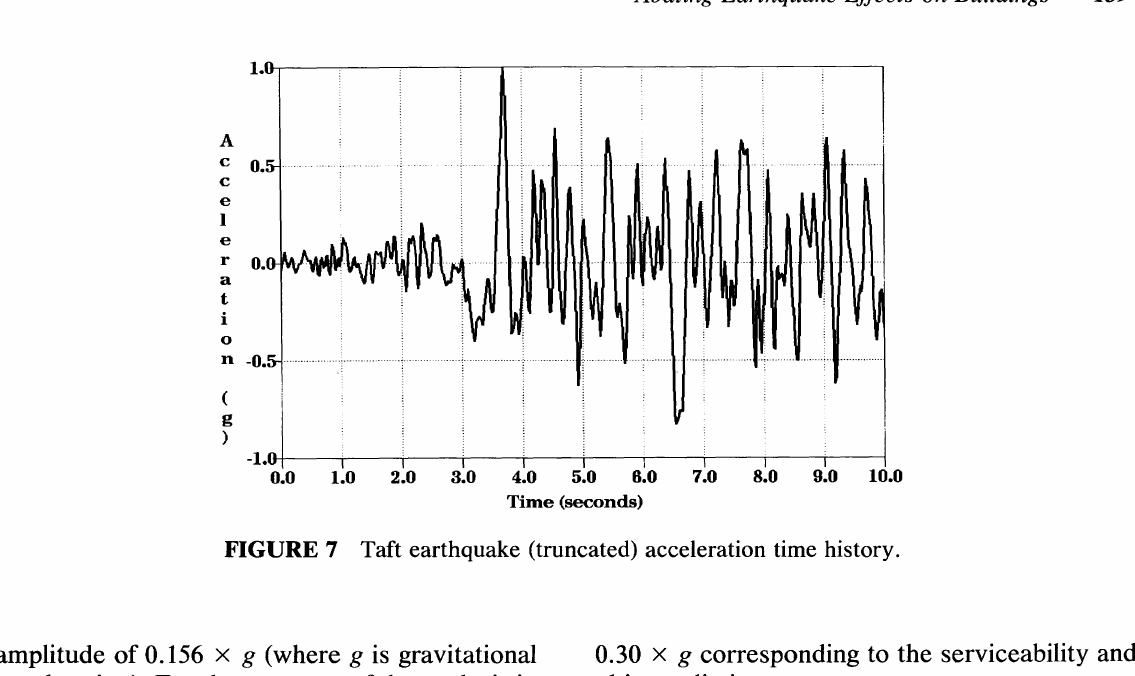
FIGURE 7 Taft earthquake (truncated) acceleration time history.